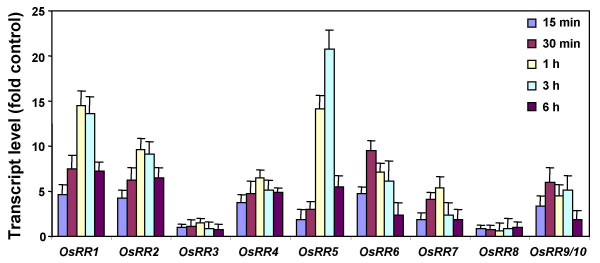
Kinetics of induction of OsRR genes in response to cytokinin. The transcript levels of each OsRR gene in 6-day-old light-grown seedlings treated with BAP for 15 min, 30 min, 1 h, 3 h and 6 h, were plotted as the relative expression (fold) of the seedlings mock-treated for the same duration.